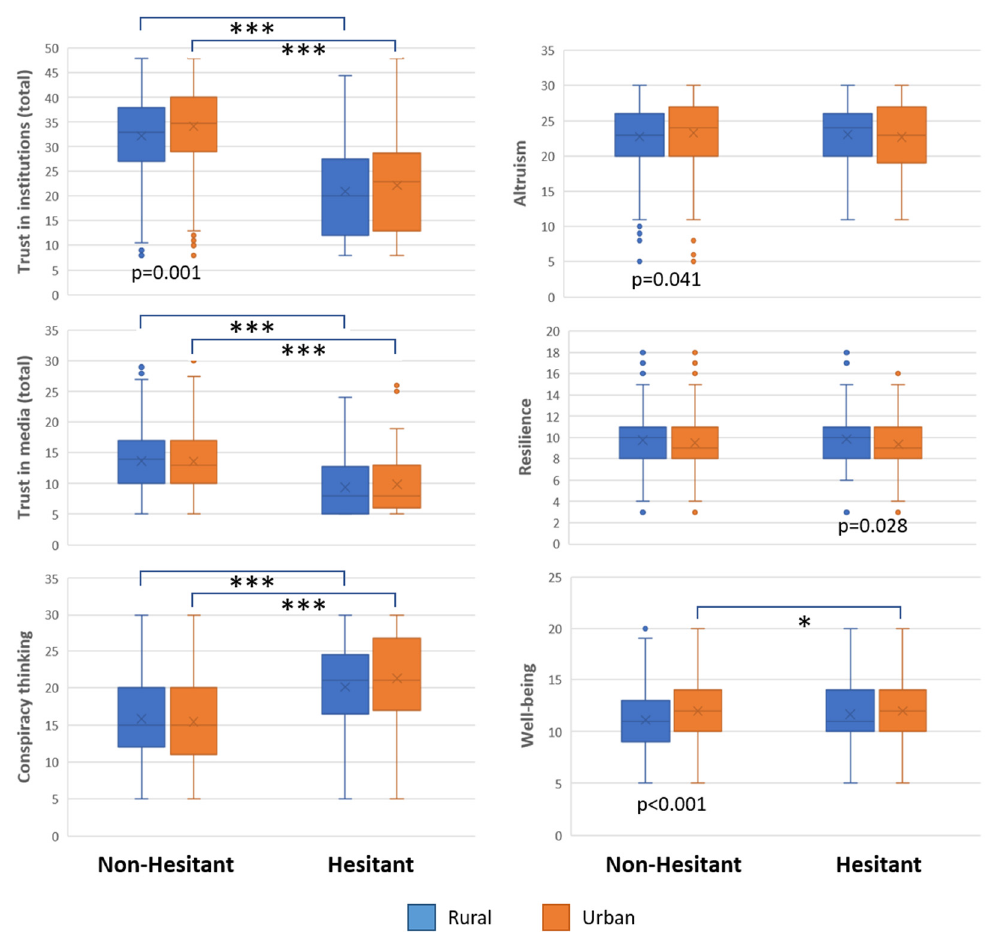
Figure 1. Box plots of (composite) scores for subgroups of rural/urban participants and answers to the question ‘Would you get vaccinated for COVID-19?” (vaccine hesitancy). P -values indicate differences between rural and urban residency; *, indicates differences between non-hesitant and hesitant. * p < 0.05, *** p <